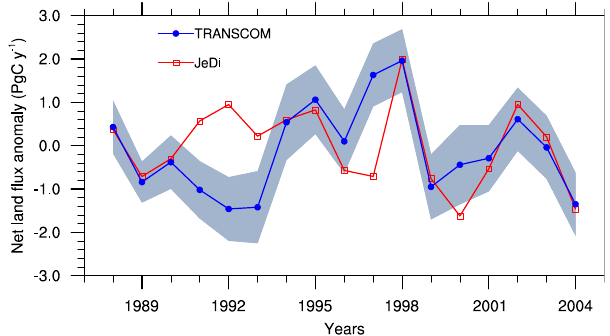
Fig. 6. Comparison of the interannual variability in the global land net ecosystem exchange fluxes from the JeDi-DGVM to the TRANSCOM atmospheric model inversion estimates (Baker et al., 2006) for years 1988–2004. The red line represents the JeDi- DGVM flux anomalies from the long-term mean. The blue line represents the mean of the 13 models from the TRANSCOM ex- periment after removing the seasonal cycle and the long-term mean for each model. The light blue shaded region represents 1 standard deviation around the TRANSCOM multimodel